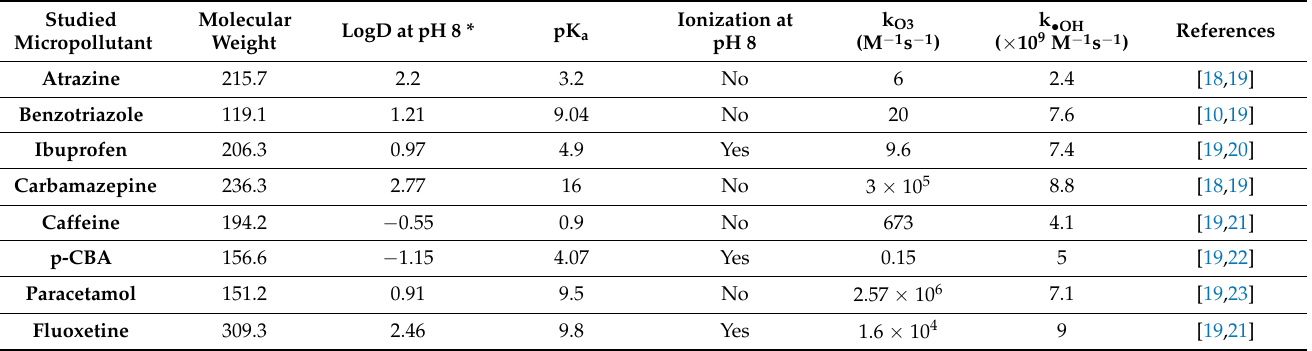
Table 1. The main physicochemical properties and the reaction rate constants with ozone and hydroxyl radicals of examined micropollutants.